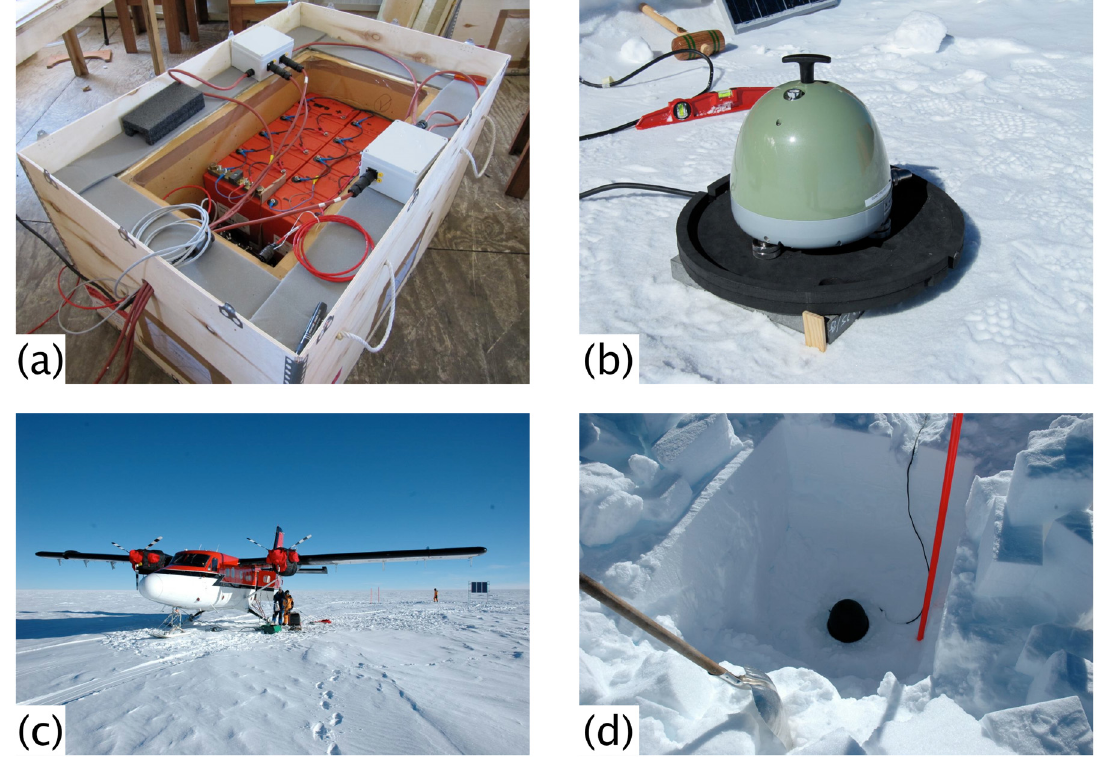
Figure 8. Deployment of the CASE-IPY profile stations. (a) Pre-installation test of the data acquisition box. (b) Pre-deployment test of the Trillium 120PA seismometer. (c) Field deployment with Twin Otter. (d) Seismometer in field pit before the installation of the protective